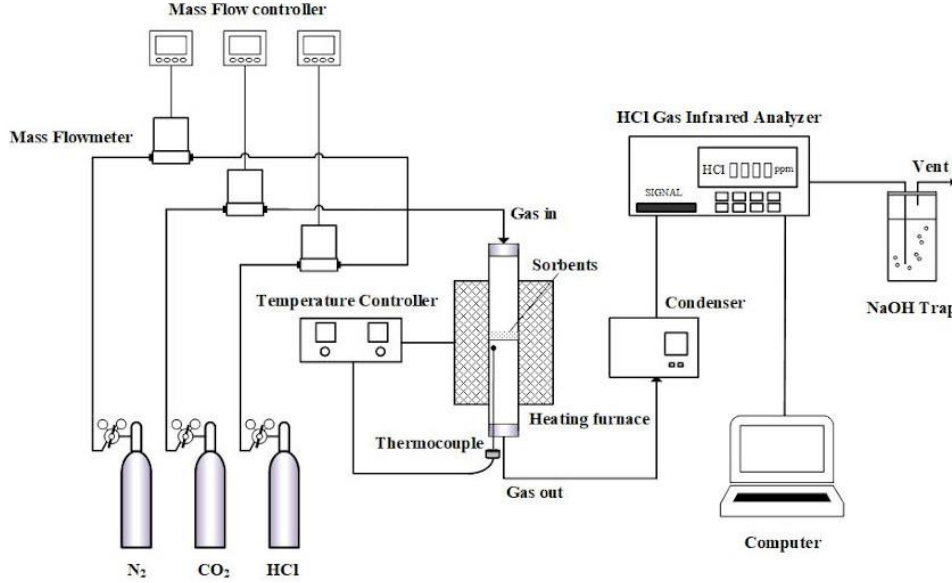
Figure 12. Schematic diagram of the experimental